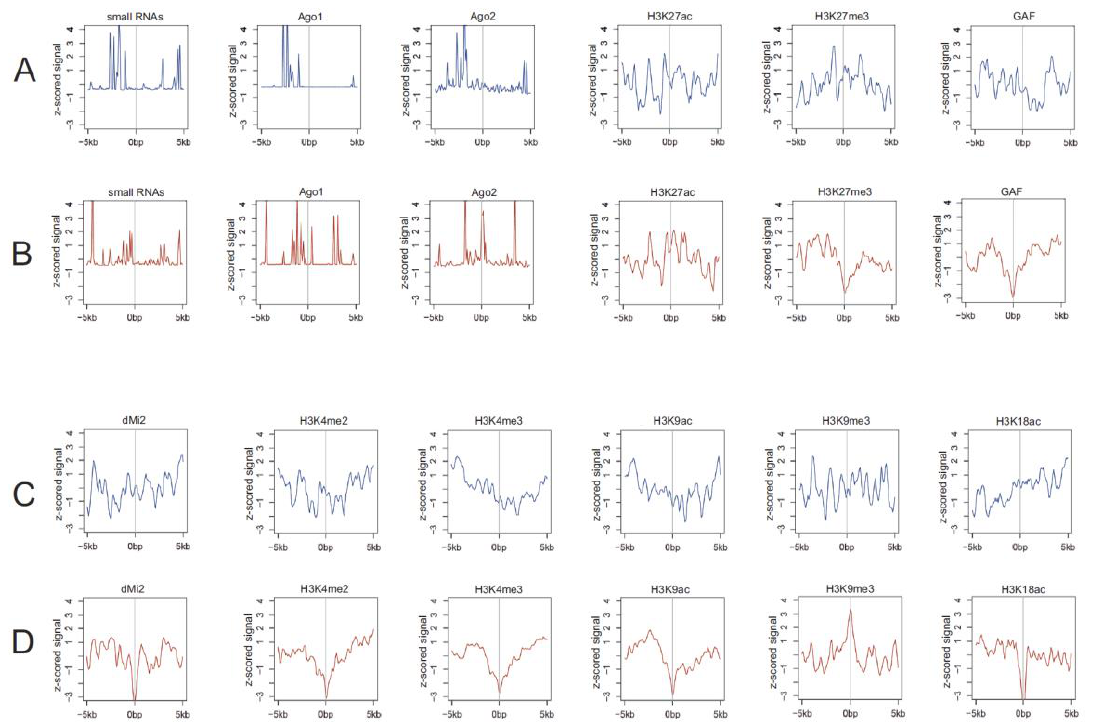
Figure 7. Profilers of small RNAs, Ago complexes, transcription factors, and histone marks around rDNA-contacting sites. The profiles shown in blue ( A , C ) and red ( B , D ) correspond to nucleoli contacts in normal and heat-shock-treated S2 cells, respectively.